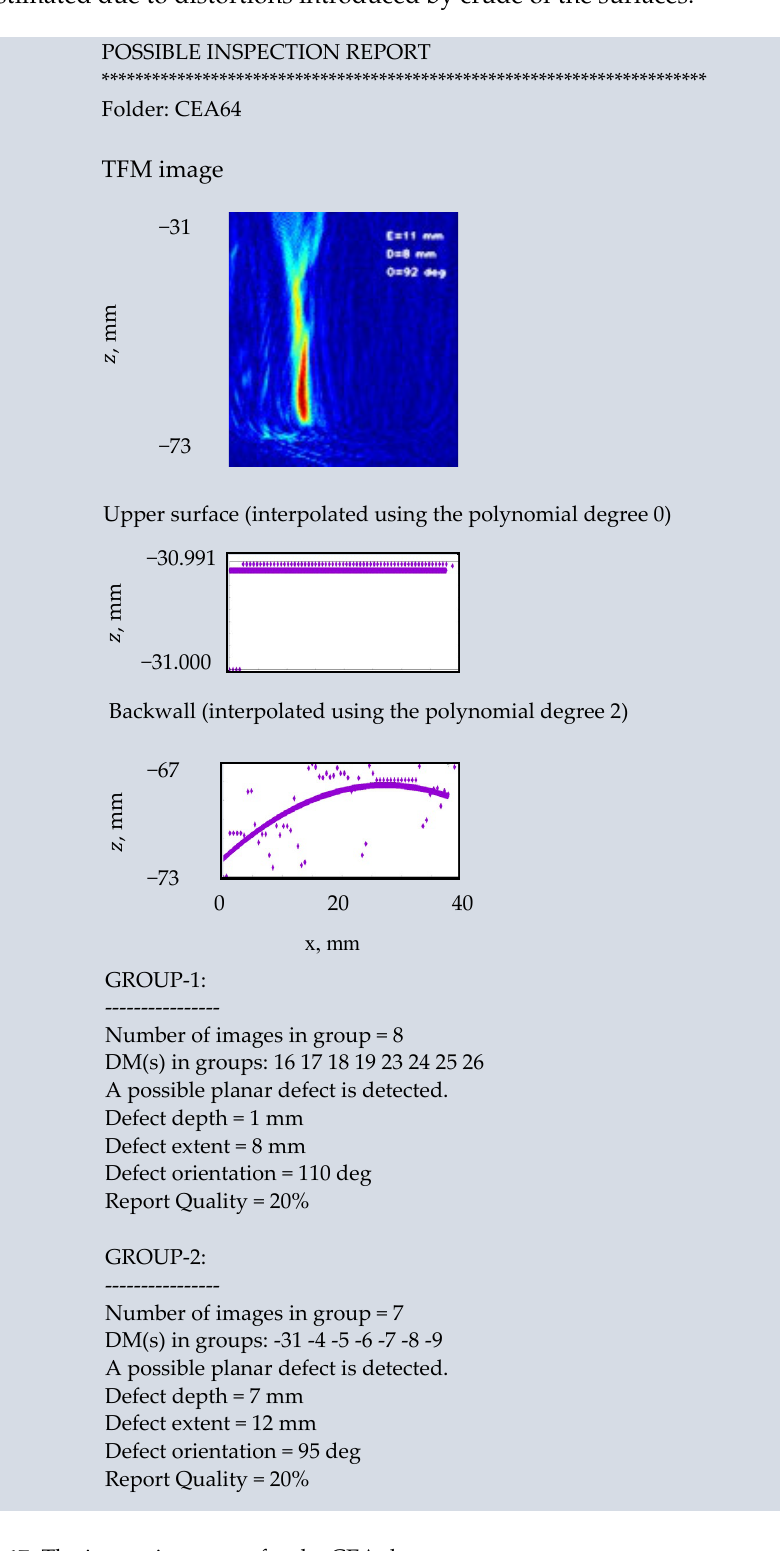
Figure 17. The inspection report for the CEA